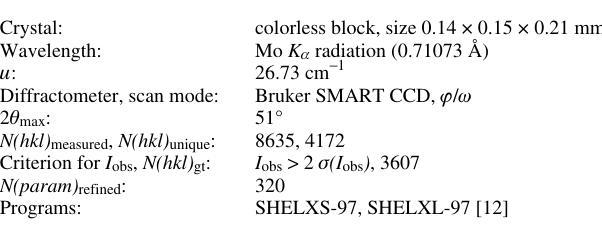
Table 1. Data collection and